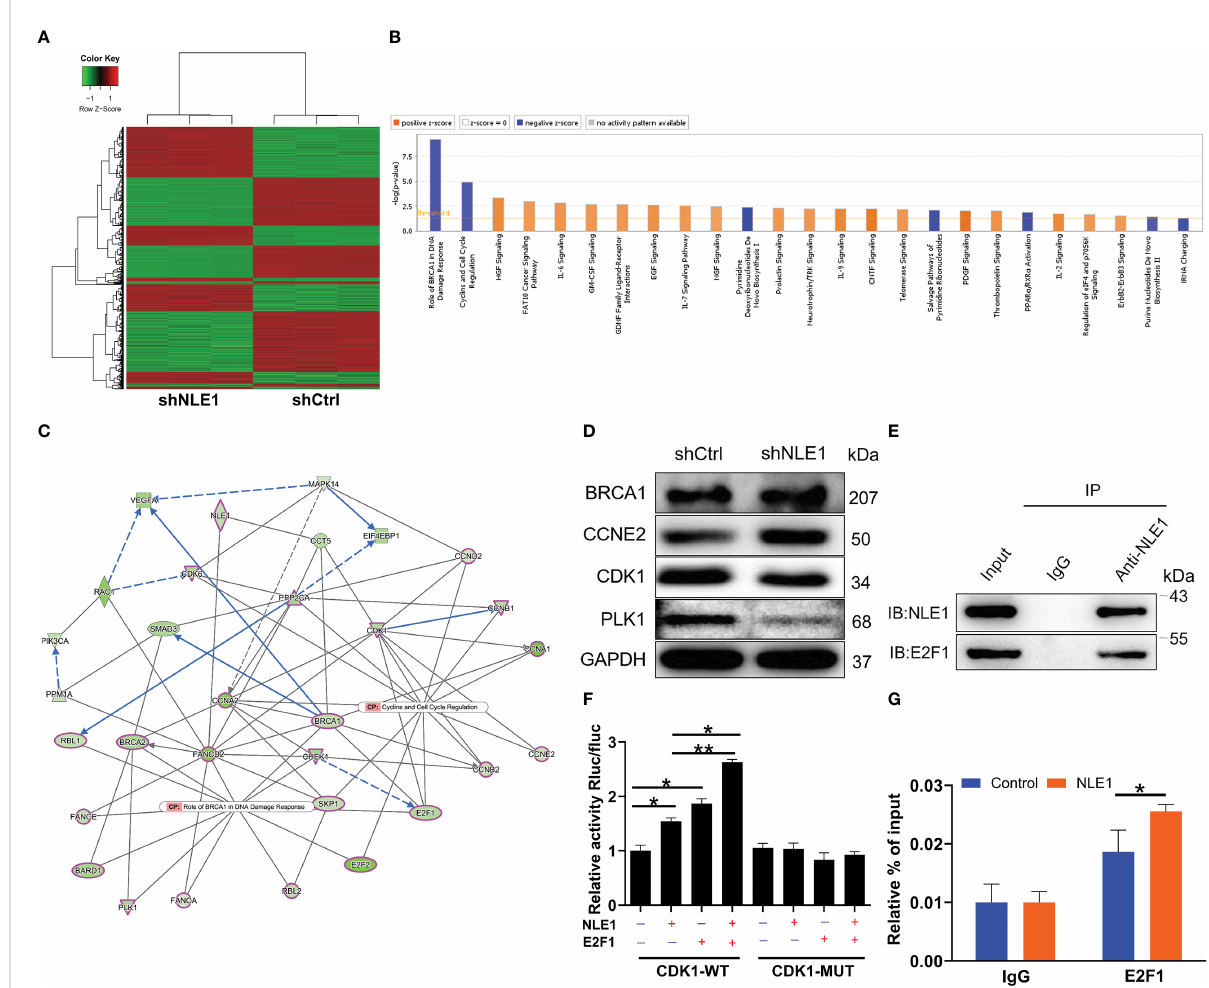
FIGURE 3 Exploration of underlying mechanism by Genechip and IPA analysis. (A) The heatmap of DEGs identi fi ed by RNA-sequencing of cells treated with shCtrl (n =3) or shNLE1 (n = 3). (B) Canonical signaling pathway based on IPA was performed to identify the pathways enrichment of DEGs. (C) Interaction network diagram between NLE1 with Role of BRCA1 in DNA Damage Response and Cyclins and Cell Cycle Regulation was analyzed by IPA. Ellipse Shape, transcription regulator; del operator, kinase; triangle, phosphatase; hexagon, translation regulator. The red outlines indicated the highlighted connectors in this network. (D) The expression of several signi fi cantly differentially expressed genes was identi fi ed by western blot in NCI-H1299 cells with shCtrl and shNLE1. (E) Co-IP assay was used to verify whether there was protein interaction between NLE1 and E2F1. (F) The dual-luciferase assay was performed to assess the interaction between E2F1 and CDK1 promotor. (G) ChIP- qPCR assay was conducted to con fi rm that NLE1 was responsible for the transcriptional regulation of CDK1 by E2F1. The data are expressed as mean ± SD (n ≥ 3). * P < 0.05, ** P <